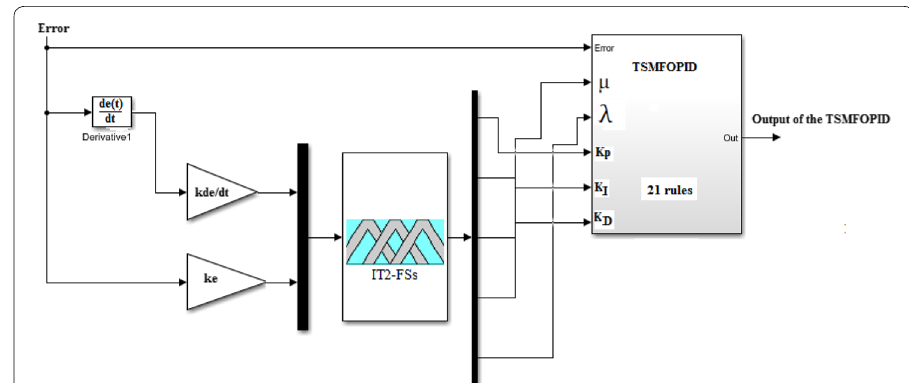
Fig. 16 Type-2 fuzzy self-tuning propose